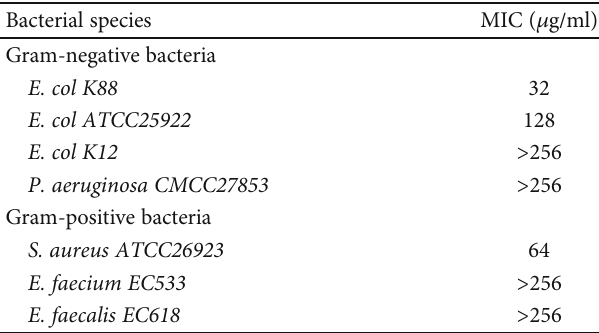
Figure 2: Isolation and identi fi cation of CBP22. (a) Cation exchange chromatography of the supernatant from C. butyricum culture medium at a wavelength of 215nm and SDS-PAGE analysis. M: mark; lane 1: before puri fi cation; lane 2: after puri fi cation. (b) A ffi nity chromatography of products from (a) at a wavelength of 215nm and SDS-PAGE analysis. M: mark; lane 1: before puri fi cation; lane 2: after puri fi cation. (c) Secondary structure prediction of CBP22. (d) Helical wheel plots of CBP22. (e) Hemolytic activity of CBP22 against porcine red blood cells. The hemoglobin release was monitored at 576 nm. The data are expressed as the mean ± SEM , n = 3 biological replicates; bars with di ff erent small capital letters are statistically di ff erent from one another. Table 2: Antibacterial activity of CBP22 measured by